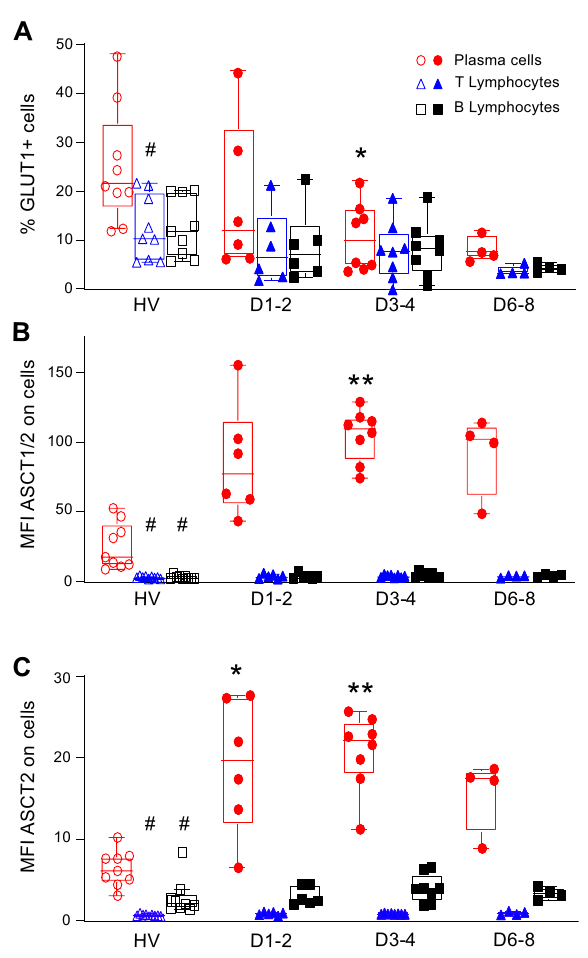
Fig. 2 Nutrient transporters expressions on T cells, B cells and plasma cells during sepsis. Expressions of GLUT1 (percentage of positive cells ‑ Panel A ), ASCT1/2 (median fluorescence intensity ‑ MFI, Panel B ) and ASCT2 (MFI, Panel C ) were assessed by flow cytometry on peripheral T cells (CD3 + lymphocytes, blue triangles), B cells (CD19 high FS low lymphocytes, black squares) and plasma cells (CD19 low FS high lymphocytes, red circles) from healthy volunteers (HV, n 9) and septic patients ( n 9) at day 1 or 2 (D1–2, n 6), day 3 or = = = 4 (D3–4, n 8) and day 6, 7 or 8 (D6–8, n 4) after the onset of septic shock. Data are represented as Tukey = = box‑plots and individual values. # p < 0.05 compared with plasma cells in HV, nonparametric Mann–Whitney U test. * p < 0.05 and ** p < 0.005 compared to identical cell population in HV. Non‑parametric ANOVA